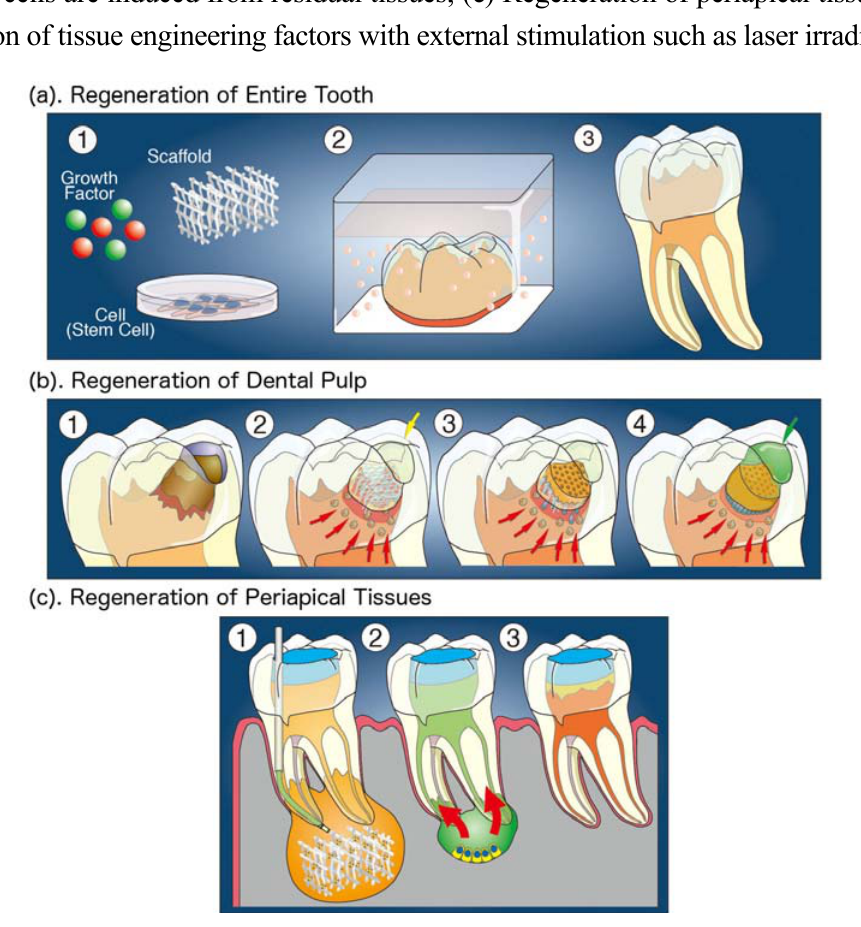
Figure 4. Schemes of strategies for the regeneration therapy of dental pulp and periapical tissues. ( a ) Regeneration of the entire tooth. In the strategy, a tooth germ is regenerated by growth factors, scaffolds, and stem cells in organ culture; ( b ) Regeneration of dental pulp and dentin. This strategy is further classified into two ways. One is the regeneration by the stem cells. The other is the regeneration by supplied growth factors and scaffolds, and stem